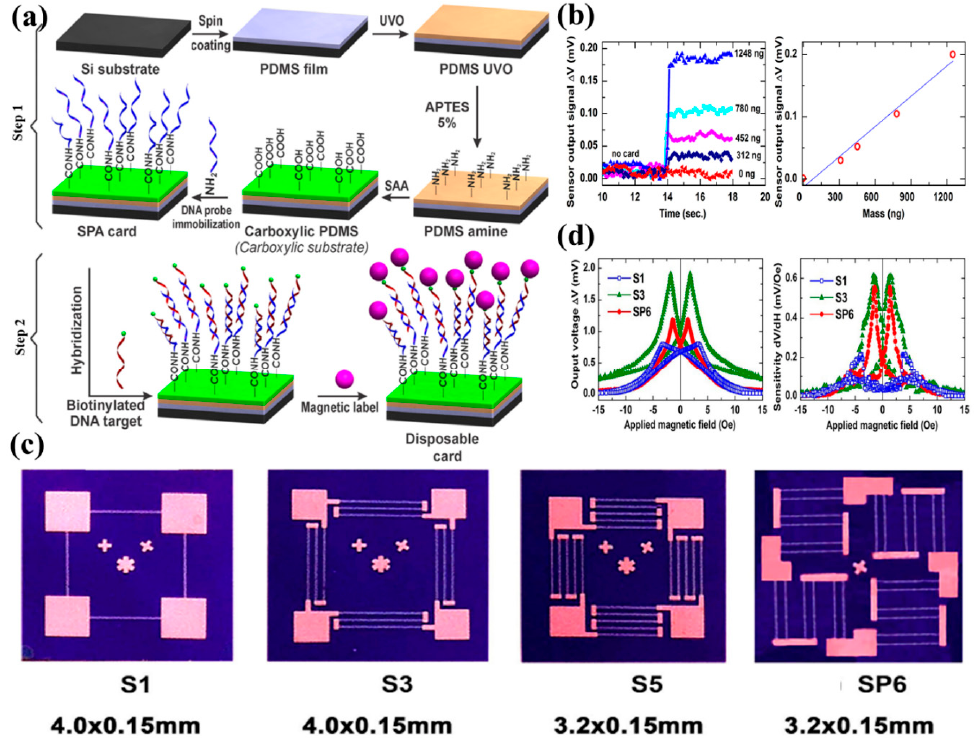
Figure 13. ( a ) The fabrication steps of the disposable SPA card and immobilization of DNA with magnetic labels as the biomarkers [119]; ( b ) the AMR sensor output with varying concentration of the MNPs and representing the lowest detectable amount of MNPs is 312 ng [119]; ( c ) the optical microscopic image of the fabricated Wheatstone Bridge AMR sensors with a single resistor (S1), three resistors in series (S3), five resistors in series (S5), and six resistors in series and parallel configuration (SP6) [120]; ( d ) magnetoresistance (in mV) and sensitivity (in mV / Oe) dependence on magnetic